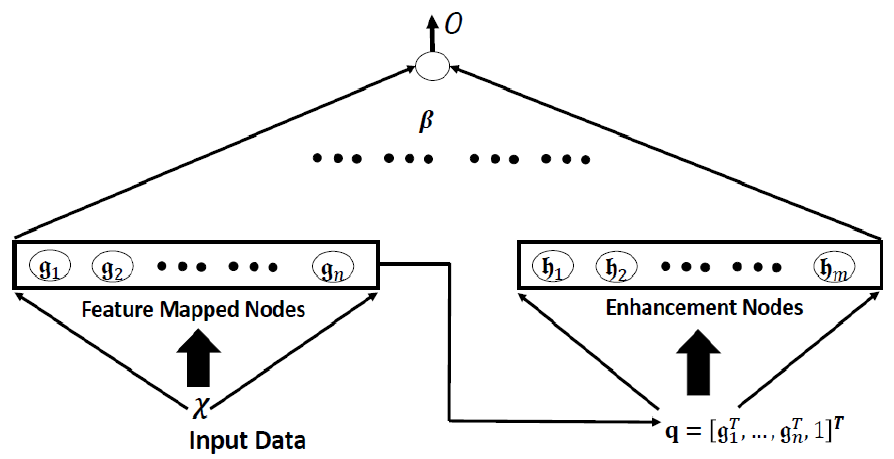
Figure 4. A typical structure of a BLS network.